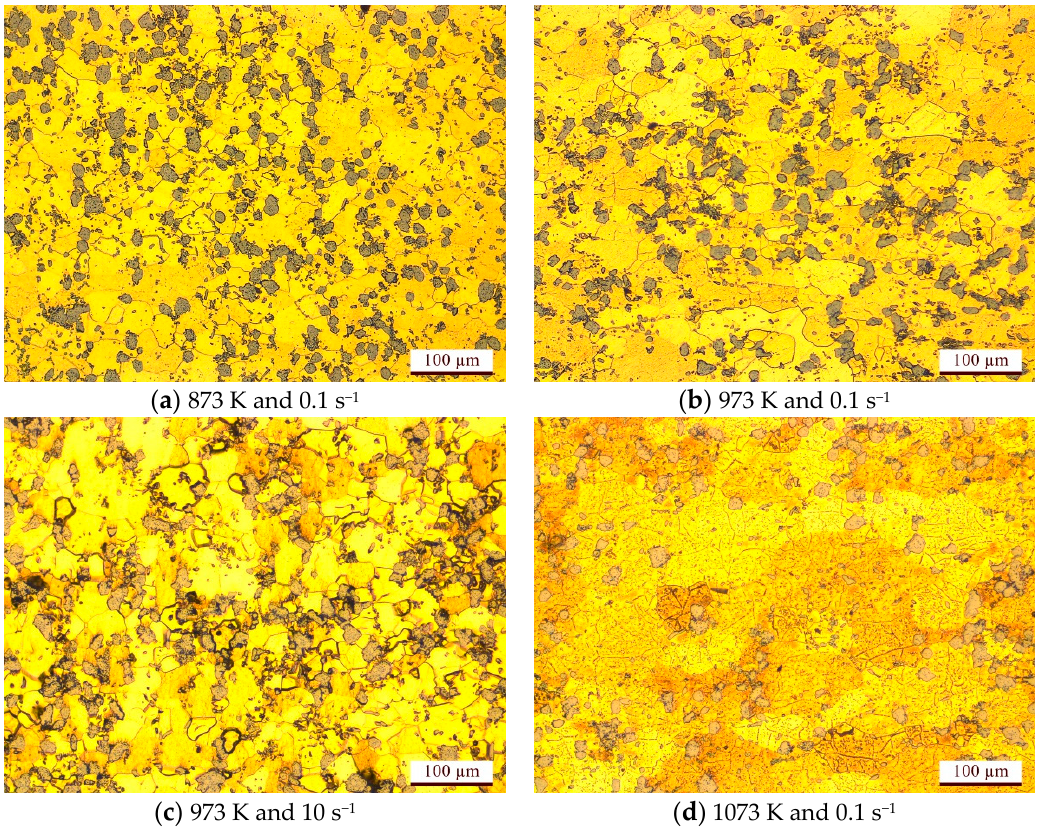
Figure 11. OM images of Cu-Ni-Al brass at safe region after deformation. Abbreviations: OM, optical microscope.